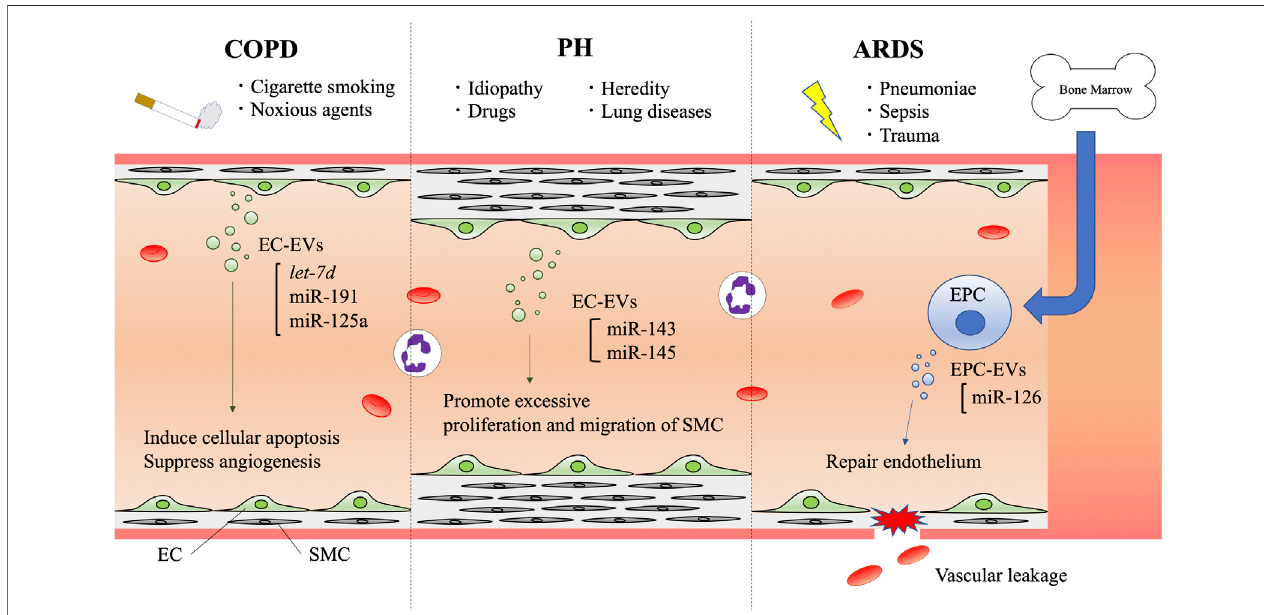
FIGURE 2 | Schematic diagram of endothelial cell-derived extracellular vesicle communication in respiratory diseases. EVs are secreted to the bloodstream by vascular endothelial cells or endothelial progenitor cells. In COPD, cigarette smoke and noxious agents induce EV secretion, and their cargoes are involved in inducing cellular apoptosis and suppressing angiogenesis. In PH, several factors such as heredity, drugs, and other lung diseases are known to cause PH. Histological features have revealed EC proliferation and SMCs with vascular remodeling. ECs and SMCs crosstalk with each other via EVs. EC-EV miR-143 and miR-145 have the potential to promote excessive proliferation and migration of SMCs. In ARDS, pneumoniae, sepsis, and trauma can induce vascular leakage. EPCs derived from bone marrow secrete EVs that contain miR-126, which can help to repair endothelium. COPD: chronic obstructive pulmonary disease, PH: pulmonary hypertension, ARDS: acute respiratory distress syndrome, EC: endothelial cell, EPC: endothelial progenitor cell, SMC: smooth muscle cell, EV: extracellular vesicle, miR: